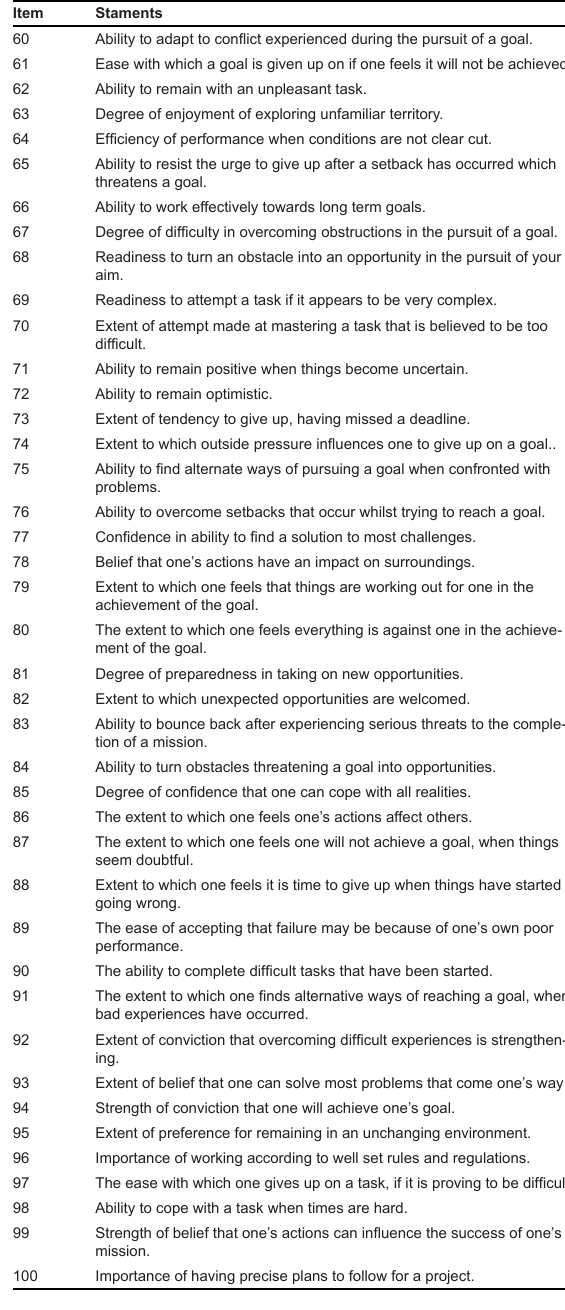
TABLE 1 Statements embedded in the items of the positive states questionnaire Item Staments 1